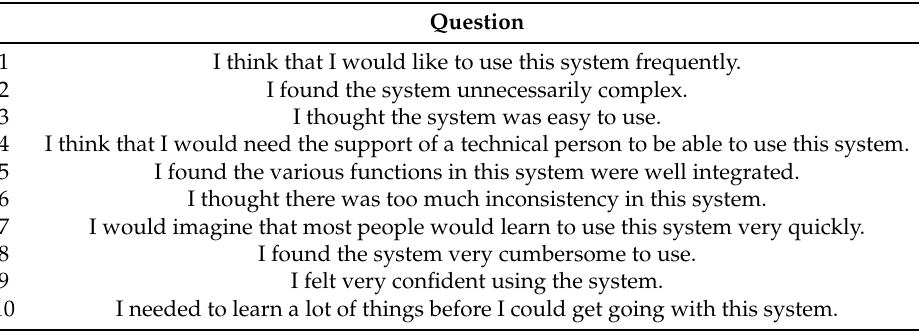
Table 1. The System Usability Scale (SUS) Questionnaire.